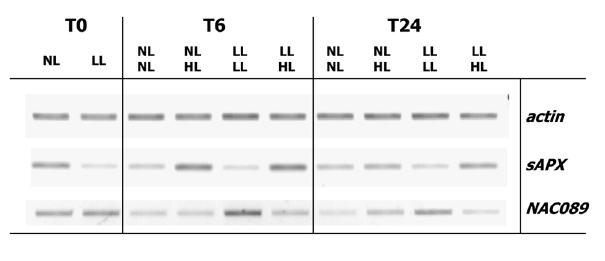
FIGURE 8 | Regulation of sAPX andANAC089 transcript amounts in a light shift experiment. A. thaliana were grown for 3 weeks in normal light, either maintained under this condition for another 10 days (80 μ mol quanta m − 2 s − 1 , N-light) or acclimated to very low light (8 μ mol quanta . m − 2 s − 1 , L-light) for 10 days.The plants were transferred to high light (800 μ mol quanta m − 2 s − 1 , H-light). Rosettes were harvested at t = 0, after 6